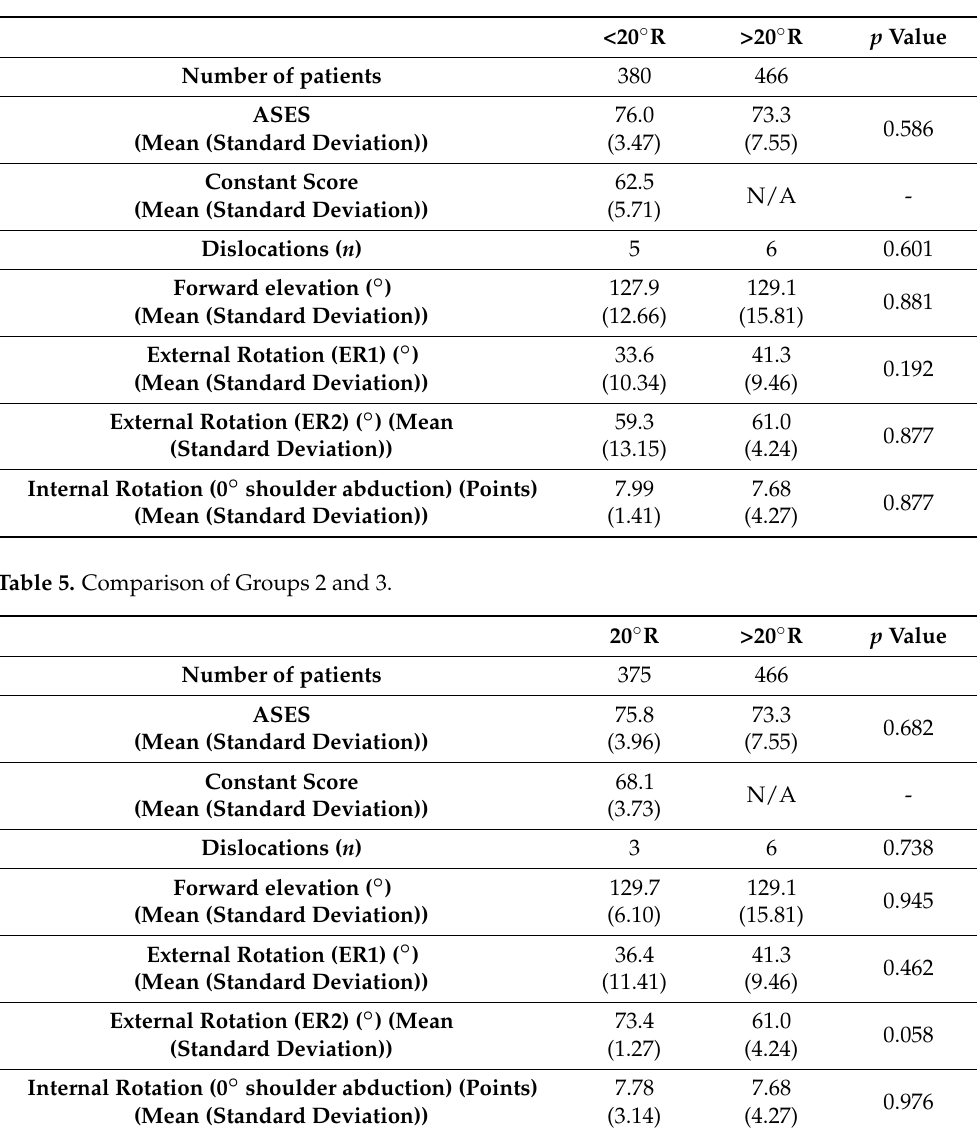
Table 4. Comparison of Groups 1 and 3.